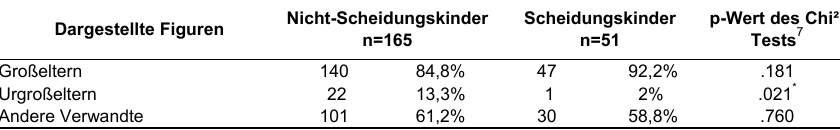
Tabelle 3: Abbildung entfernter Verwandter Dargestellte